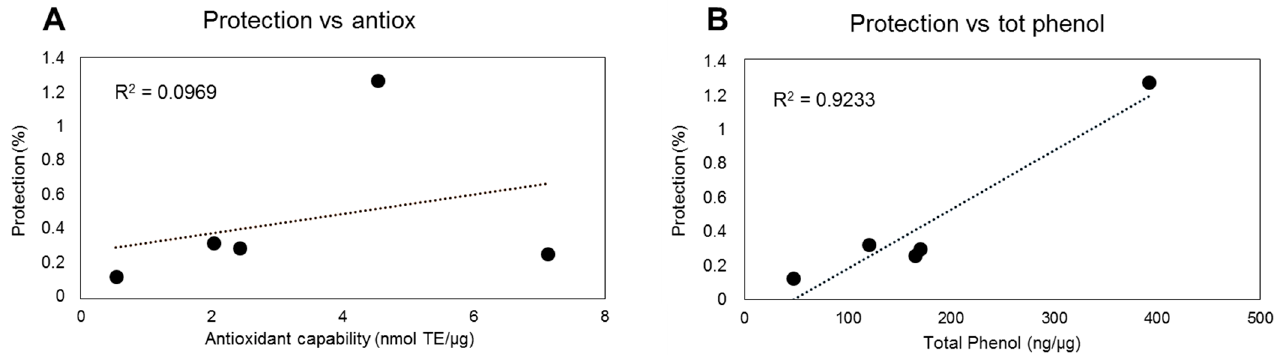
Figure 4. Correlation between protective effect of extracts from plant food-derived matrices and their antioxidant capability ( A ) and total phenol content ( B ). The protective effect of different phenolic plant extracts (1 µ g) was correlated with their antioxidant capability or total phenol content.